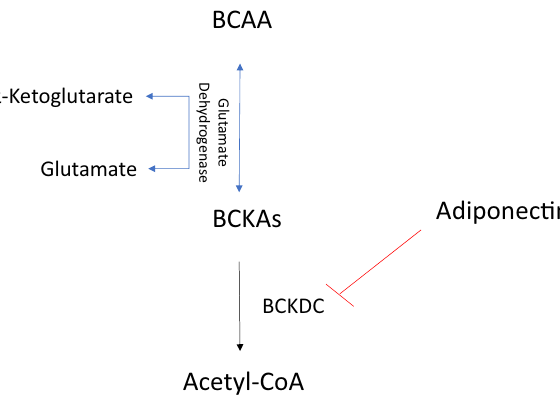
Figure 4. Inhibition by adiponectin on branched-chain amino acids catabolism [27]. Branched chain amino acids (BCAAs); Branched chain alpha keto acids (BCKAs); Branched-chain α-ketoacid dehydrogenase complex (BCKDC).